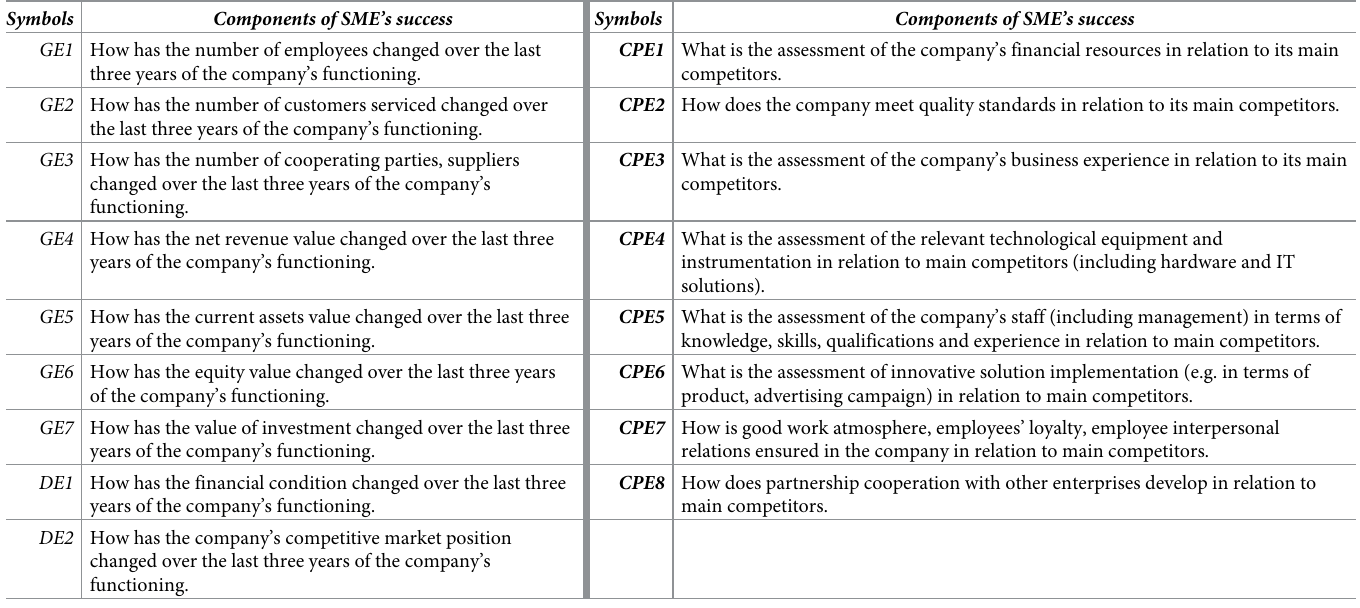
Table 2. Dimensions of SMEs success (components of SME’s success).